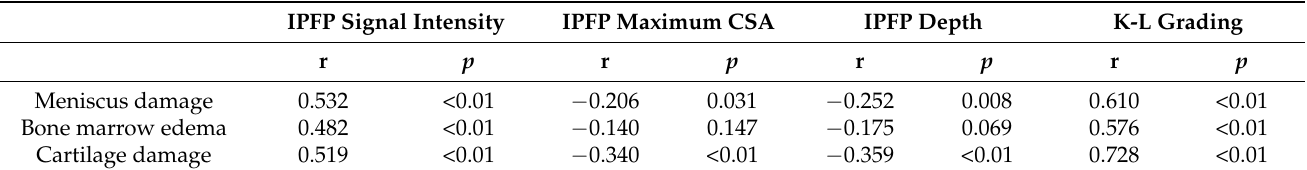
Table 3. Correlation between imaging changes of the knee under MRI with IPFP signal intensity alternation, IPFP maximum CSA, IPFP depth and K-L